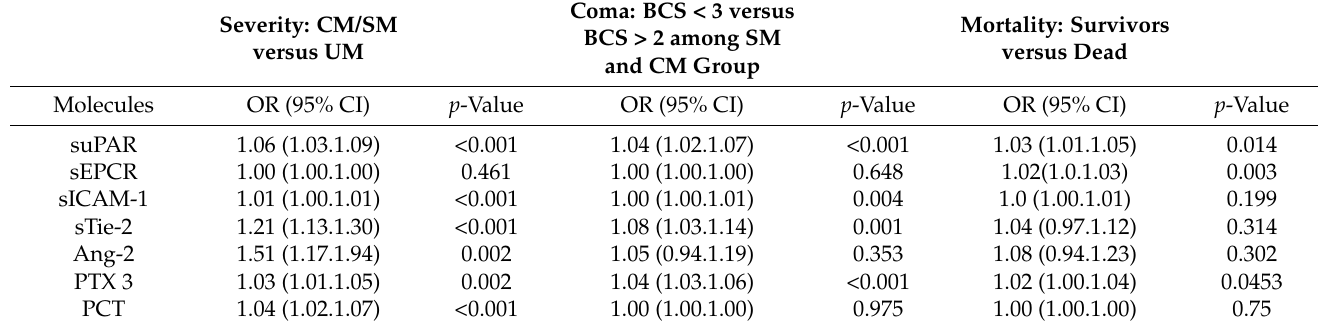
Table 2. Relationship between suPAR, sEPCR, sICAM-1, sTie-2, Ang-2, PTX3 and PCT levels and malaria outcomes. Odds ratios for various outcomes when testing 7 analytes as potential predictors of severity, coma and